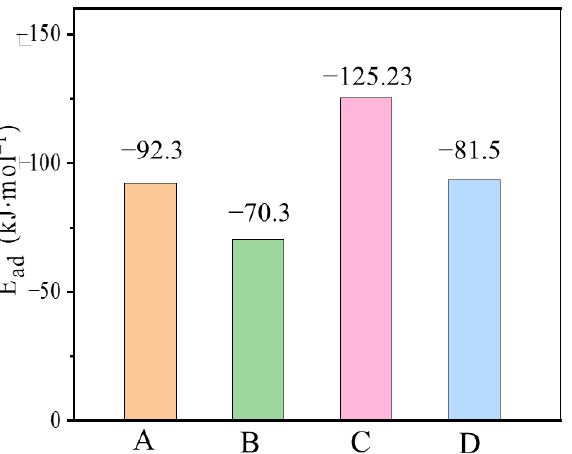
Figure 12. The Ead on CuS (110) of Hg 0 with different sites (A: di-coordinated Cu, B: tri-coordinated Cu, C: tri-coordinated S, and D: tetra-coordinated S. The structural configurations shown in Figure S4).